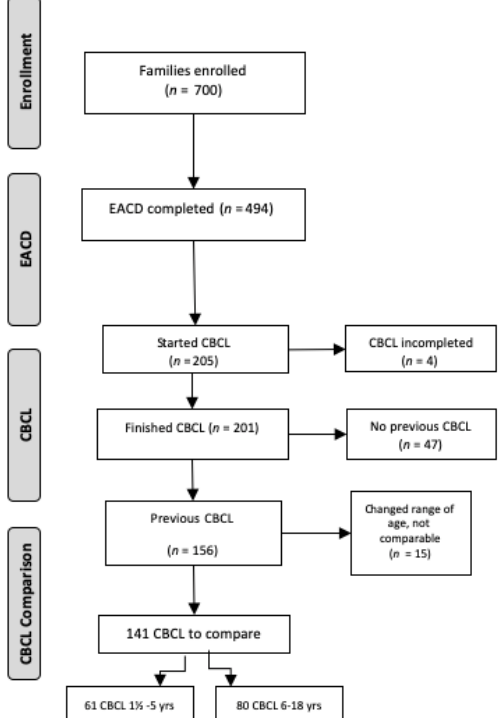
Figure 1. Patients Recruitment Flowchart. Abbreviations: EACD = European Academy of Childhood Disability; CBCL = Child Behaviour Checklist.